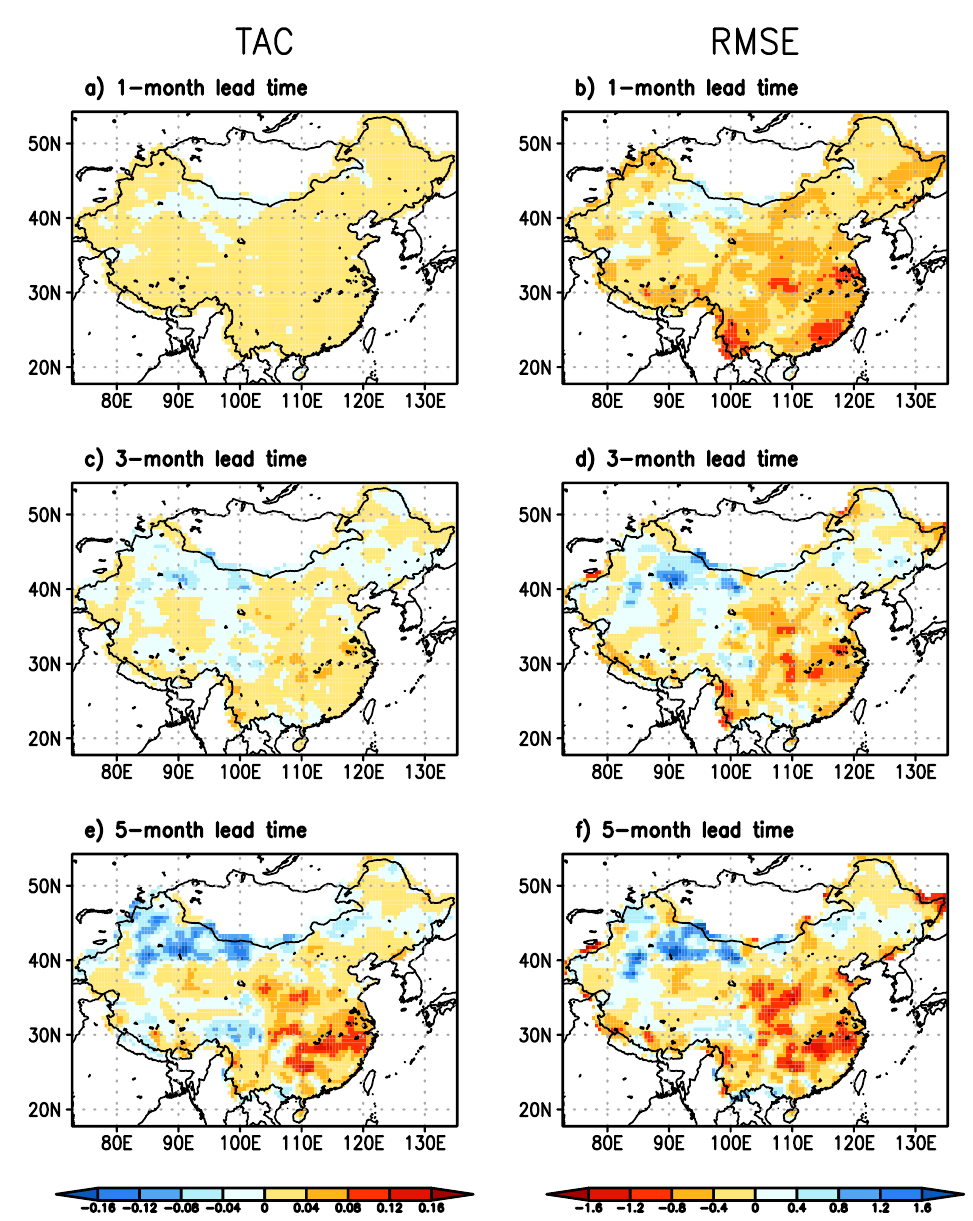
Figure 2. Similar to Figure 1, but for the difference in skills between the Climate Forecast System version 2 (CFSv2) forecast and persistence